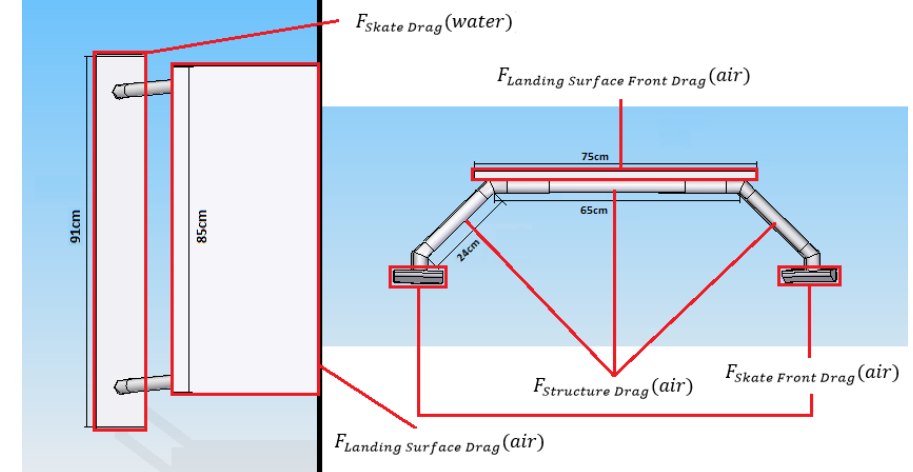
Figure 5. Forces affecting the system. On the left : areas of the skate and landing surface where the water and air resistance forces affect, respectively. On the right : frontal areas affected by